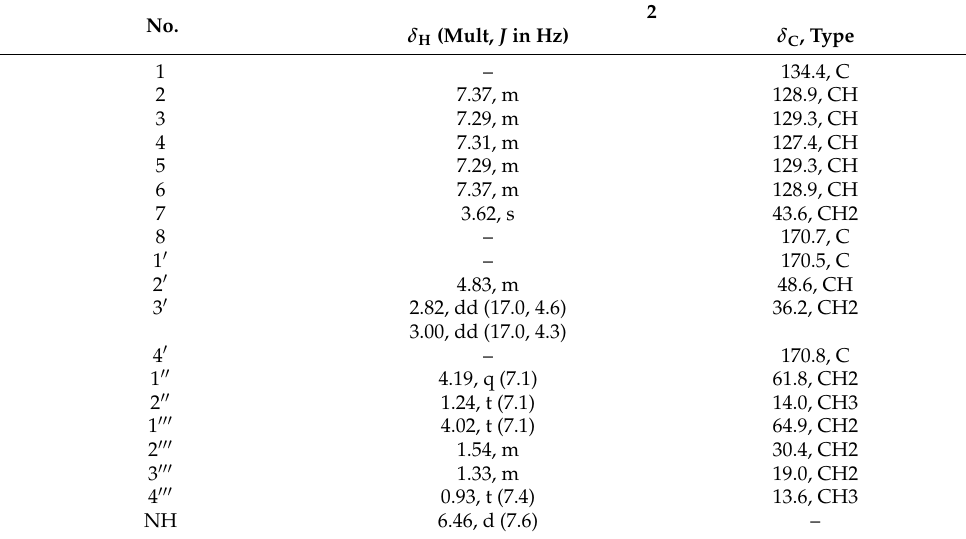
Table 2. 1 H NMR (700 MHz) and 13 C NMR (175 MHz) spectroscopic data of 2 in CDCl 3 . 2 No. δ H (Mult, J in